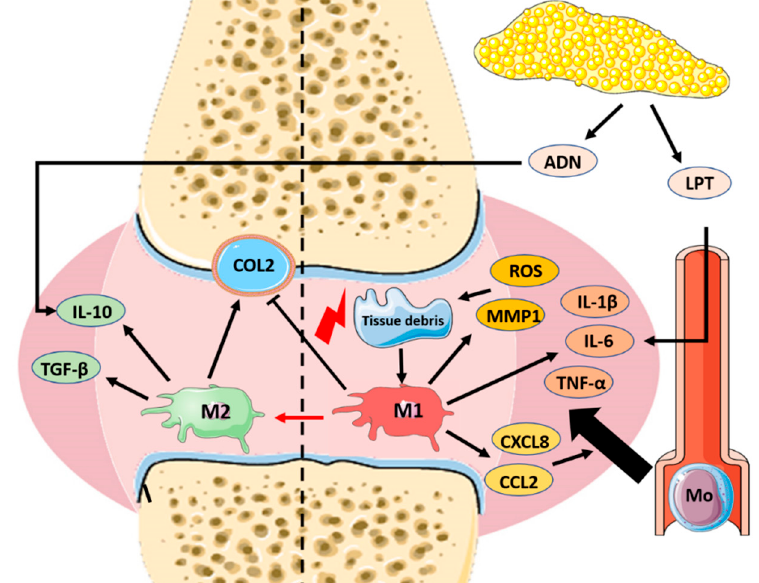
Figure 2. Role of macrophages in the pathophysiology of osteoarthritis. Acute trauma or chronic overuse of the joint results in the activation of resident synovial macrophages toward a harmful pro-inflammatory M1-like phenotype. Once activated, synovial M1-macrophages secrete signaling molecules, such as pro-inflammatory cytokines (interleukin (IL)-1 β , tumor necrosis factor alpha (TNF- α ), IL-6 and chemokines (CCL-2, CXCL-8) that lead to further leukocyte recruitment, including monocytes (Mo) that infiltrate the joint, become activated toward an M1-like phenotype, and contribute to the thickening of the synovia (a key morphological feature of synovitis). These M1 macrophages also produce matrix metalloproteinases (MMP1) and reactive oxygen species (ROS), which damage directly the joint, worsening the tissue injury and leading to a positive feedback pro-inflammatory loop. Furthermore, M1 macrophages can directly inhibit chondrogenesis through the inhibition of collagen type 2 (COL2) synthesis by mesenchymal stem cells (MSCs) in the joint. Tissue debris and molecules released from the degradation of hyaline cartilage and subchondral bone, which are related to damage of the meniscus, are responsible for the pro-inflammatory properties of the synovial fluid from the early stages of knee OA [45]. In contrast, the polarization of macrophages in the joint toward an M2-like anti-inflammatory phenotype has beneficial effects for the repair of the injury and for the cure of OA disease. It has been demonstrated that M2 macrophages are able to promote cartilage repair through the secretion of TGF- β and IL-10. Once secreted in the synovial fluid, the latter exert their pro-chondrogenic effect by stimulating chondrocytes to secrete type II collagen and proteoglycans. This beneficial action of “alternatively activated” M2 macrophages finds a clinical counterpart in a recent in vivo experiment that correlated the imbalance of M1/M2 ratio as a feature of the severity level of knee OA [10]. In addition to the local triggers of OA, the systemic immune status of the patient is a key responsible for the evolution of the disease. As examples, increased levels of systemic leptin (LPT) increase IL-6 secretion in the joint, supporting deleterious inflammation, while systemic adiponectin (ADN) has shown a protective role by upregulating the secretion of IL-10 in the articulations. Importantly, recent clinical studies have correlated the increased M1/M2 ratio with a higher severity of knee OA disease.